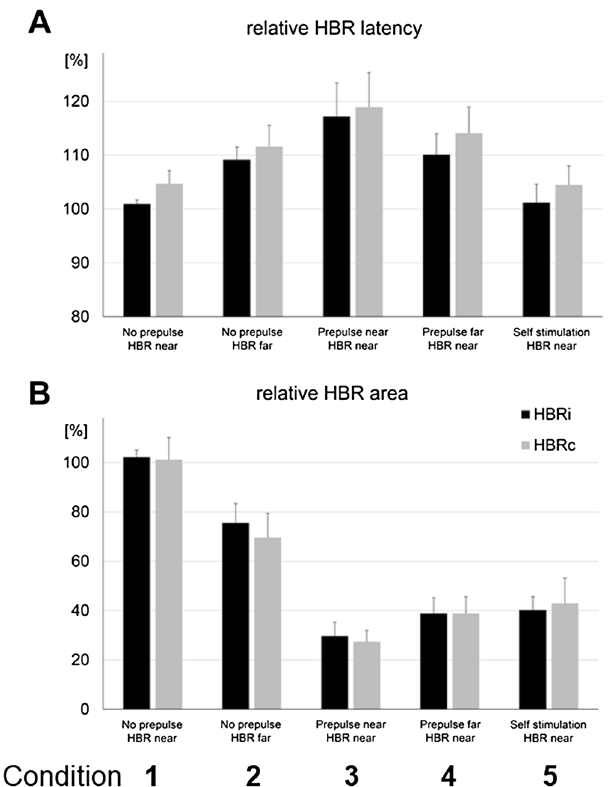
Figure 2. The columns represent normalized group data for onset latency ( A ) and area ( B ) of HBRs recorded in orbicularis oculi muscle ipsi- (black columns) and contralateral (gray columns) to dominant median nerve stimulation in experimental conditions 1–5 (see text for details). The columns are mean values (whiskers are mean standard errors) for group average data in percentage of individual median values of the orbicularis oculi muscle ipsilateral to the stimulated dominant median nerve in condition 1 ( no-prepulse-HBR-near